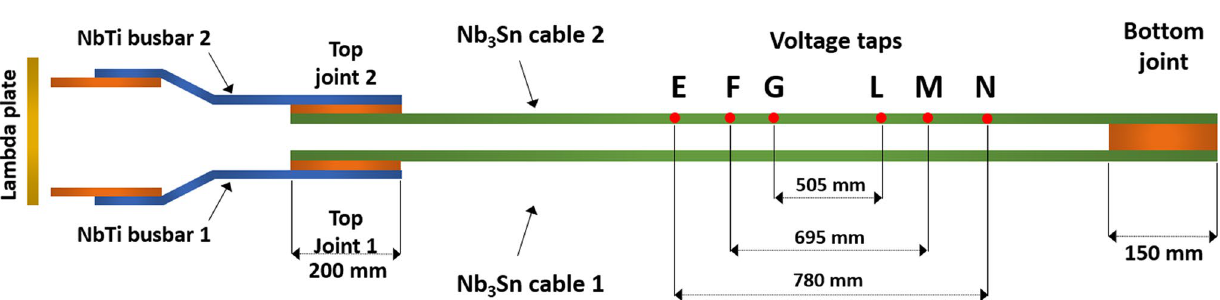
Figure 7. The electrical scheme used for the cable’s I c measurements in the FReSCa test facility at